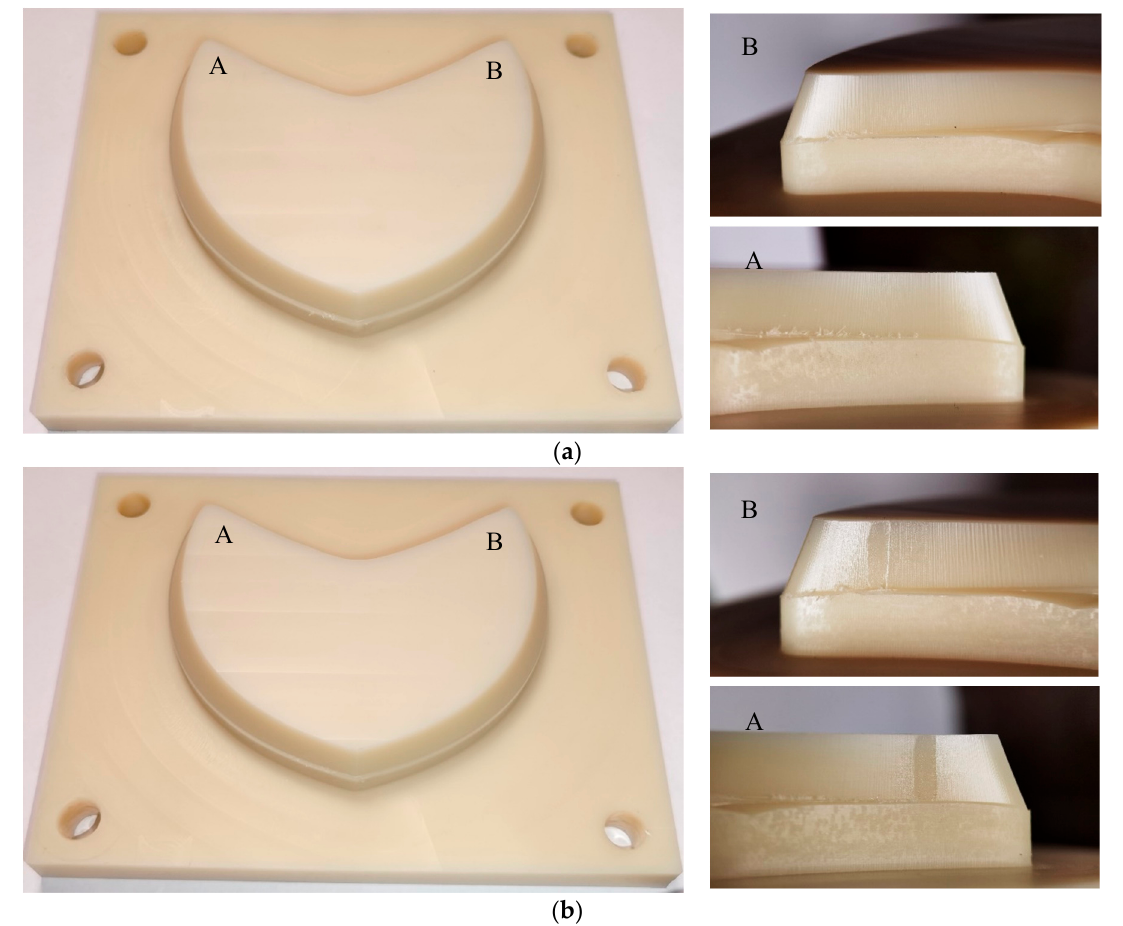
Figure 11. The machining results of the cardioid curve interpolation. ( a ) The rotation angles solved by the proposed method. ( b ) The rotation angles solved by the inverse trigonometric method.